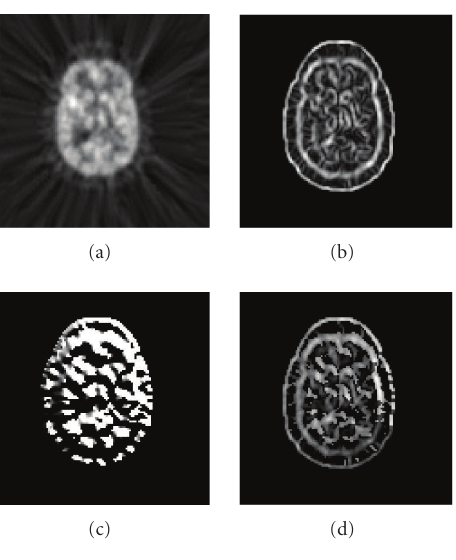
Figure 4: Weighing functions f ( v ( E i , E g )) with T = 0 . 0025 (green), T = 0 . 01 (magenta), T = 0 . 04 (blue), T = 0 . 16 (black) and T = 0 . 64 (red),